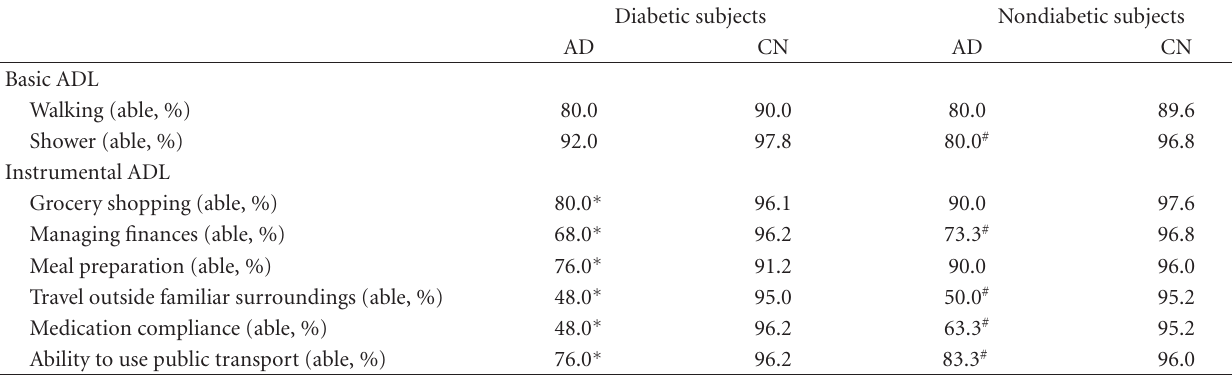
Table 3: Self-reporting of basic and instrumental activities of daily living